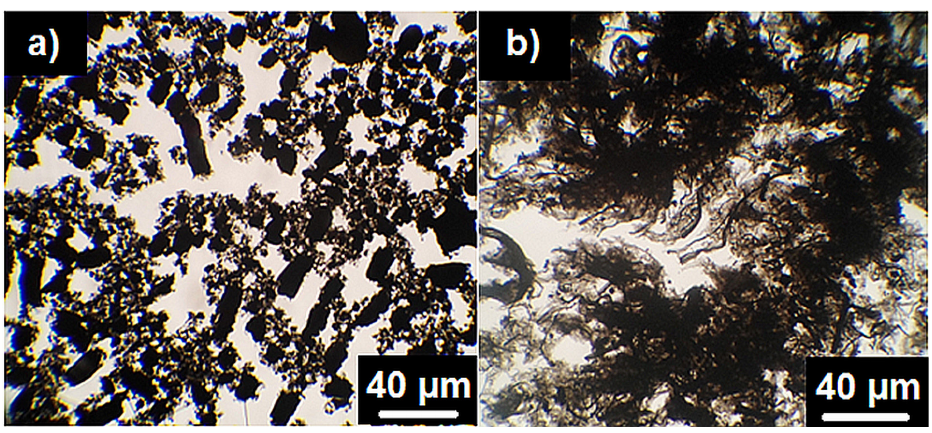
-CNT gel, different phases of the material are clearly observed; (b) MTICl-Ti(OBu) 4